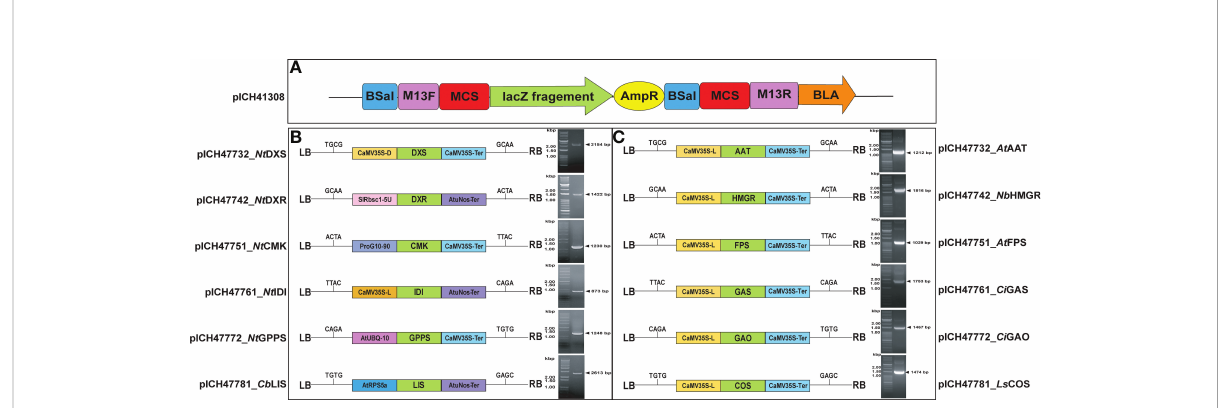
FIGURE 2 MoClo golden gate vector construction map. (A) Level-0 (Entry level vector), (B, C) . MVA and MEP pathway gene constructs and PCR ampli fi cation of gel products (AAT, 1.2 kb; HMGR, 1.8 kb; FPS, 1.0 kb; GAS, 1.7 kb; GAO, 1.4 kb and COS, 1.4 kb, DXS, 2.1 kb; DXR, 1.4 kb; CMK, 1.2 kb; IDI, 0.8 kb; GPPS, 1.2 kb; and LIS, 2.6 kb) were isolated and cloned into the MoClo golden gate vector. The expression cassette is located between the left and right T-DNA boarders (LB and RB, respectively) and contain s the cauli fl ower mosaic virus 35S promoter and